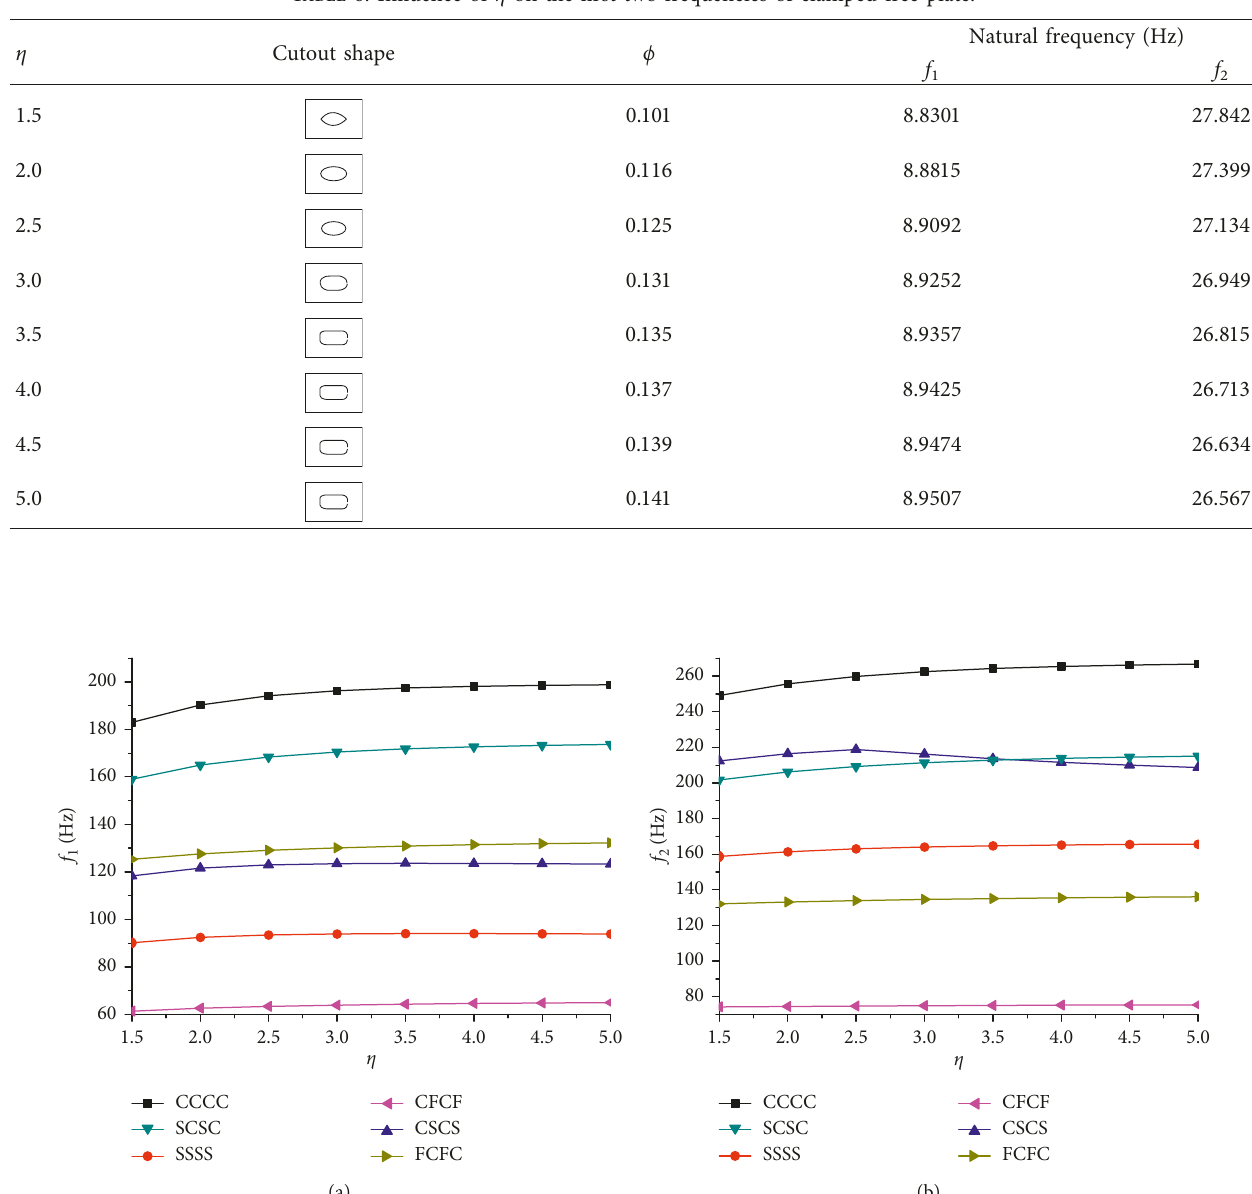
Table 6: Influence of η on the first two frequencies of clamped-free plate.